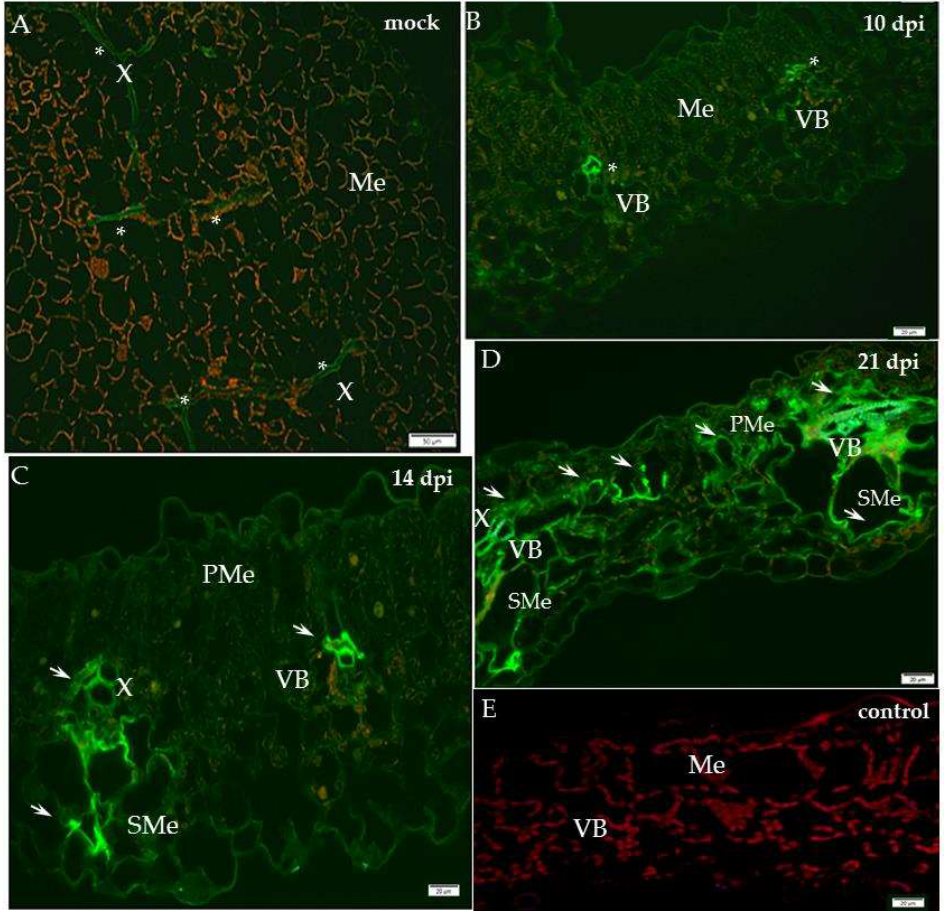
Figure 1. Immunofluorescence localisation of xylan-1/xyloglucan in potato–PVY NTN compatible interaction. ( A ) Green fluorescence signal of xyl-1 in xylem tracheary elements ( * ) of mock-inoculated potato leaf on longitudinal section (control). Bar 50 µm. ( B ) Green fluorescence of xyloglucan in vascular bundle (VB, * ) and in low intensity in mesophyll 10 days post-PVY NTN inoculation. Bar 20 µm. ( C ) Fluorescence of xyl-1/xyloglucan in vascular bundle (arrows, phloem and xylem) and spongy mesophyll cells 14 days post-PVY NTN inoculation. Lower intensity of signal in mesophyll. Bar 20 µm. ( D ) Strong signal of xyl-1/xyloglucan (arrows) in vascular bundle (phloem & xylem) of both types of mesophyll. Strong reorganisation of tissues’ patterns 21 days post-virus inoculation. Bar 20 µm. ( E ) Lack of green fluorescence signal when primary antibodies were omitted–control. Bar 20 µm.